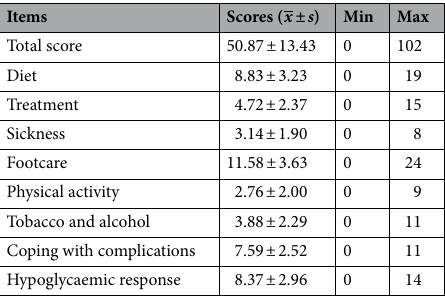
Table 3. AD knowl scores.